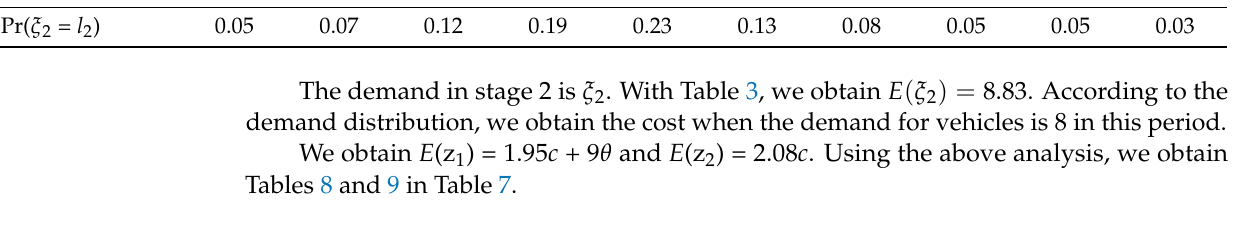
Table 7. Total cost in two periods (with the demand for vehicles in this period = 8).